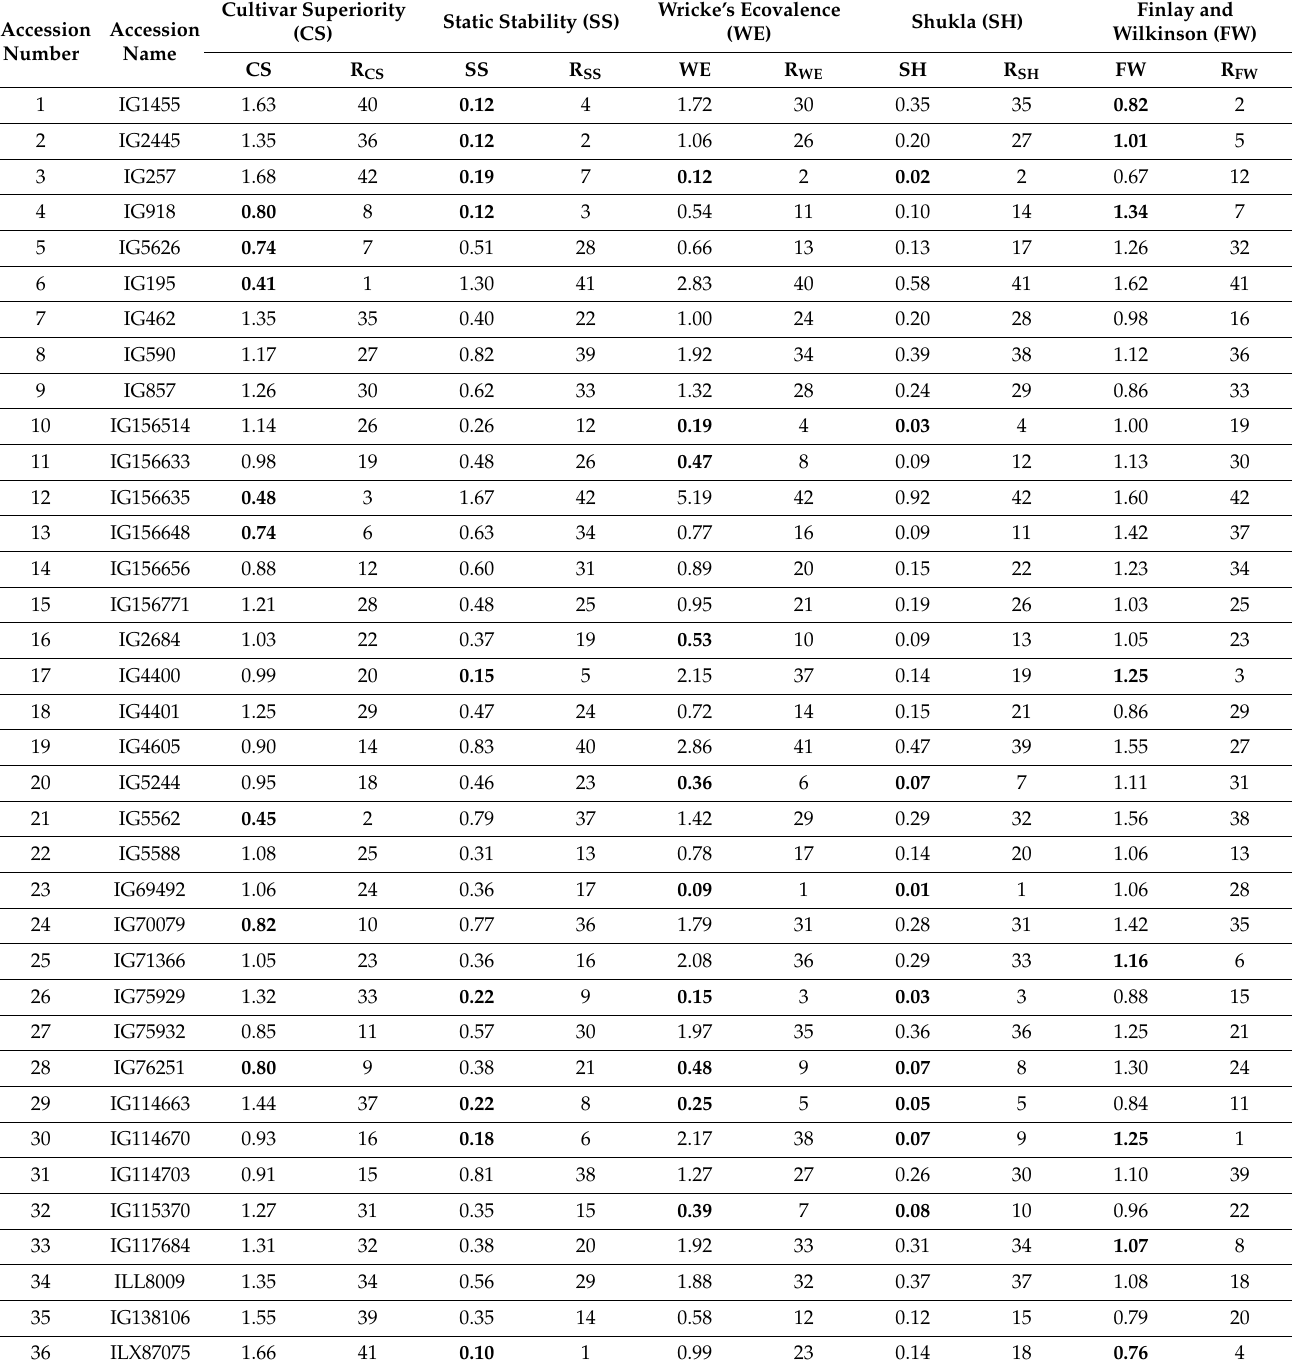
Table 4. Five Stability parameters for grain yield of selected lentil accessions and their rankings in eight different